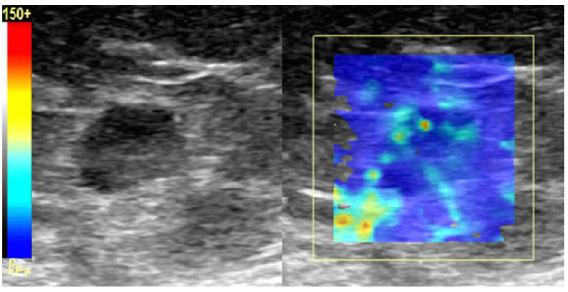
Fig 1. B-mode and elastography images in axial plane of an inguinal lymph node (LN) from a 68-year old patient with vulvar cancer. Although the B-mode image shows a slightly rounded LN, elastography shows the LN as blue (soft) indicating benign etiology. In histopathology, the inguinal lymph nodes proved to be